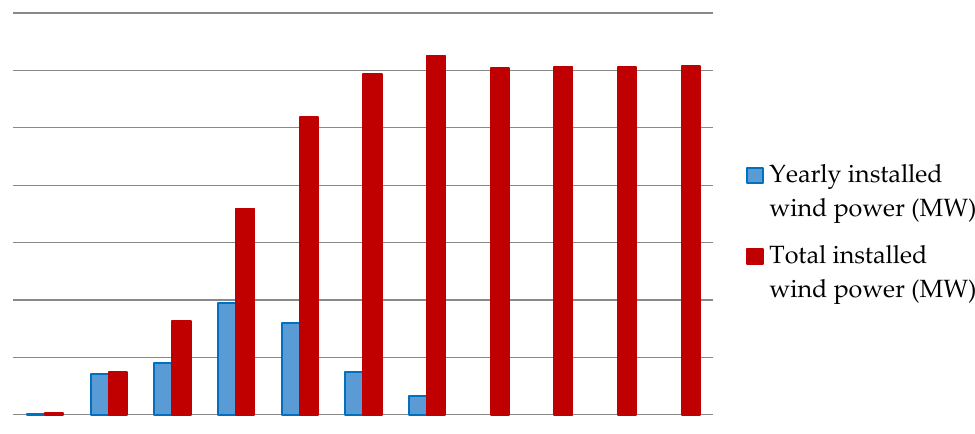
Figure 1. The evolution of wind power capacities installed in Romania.